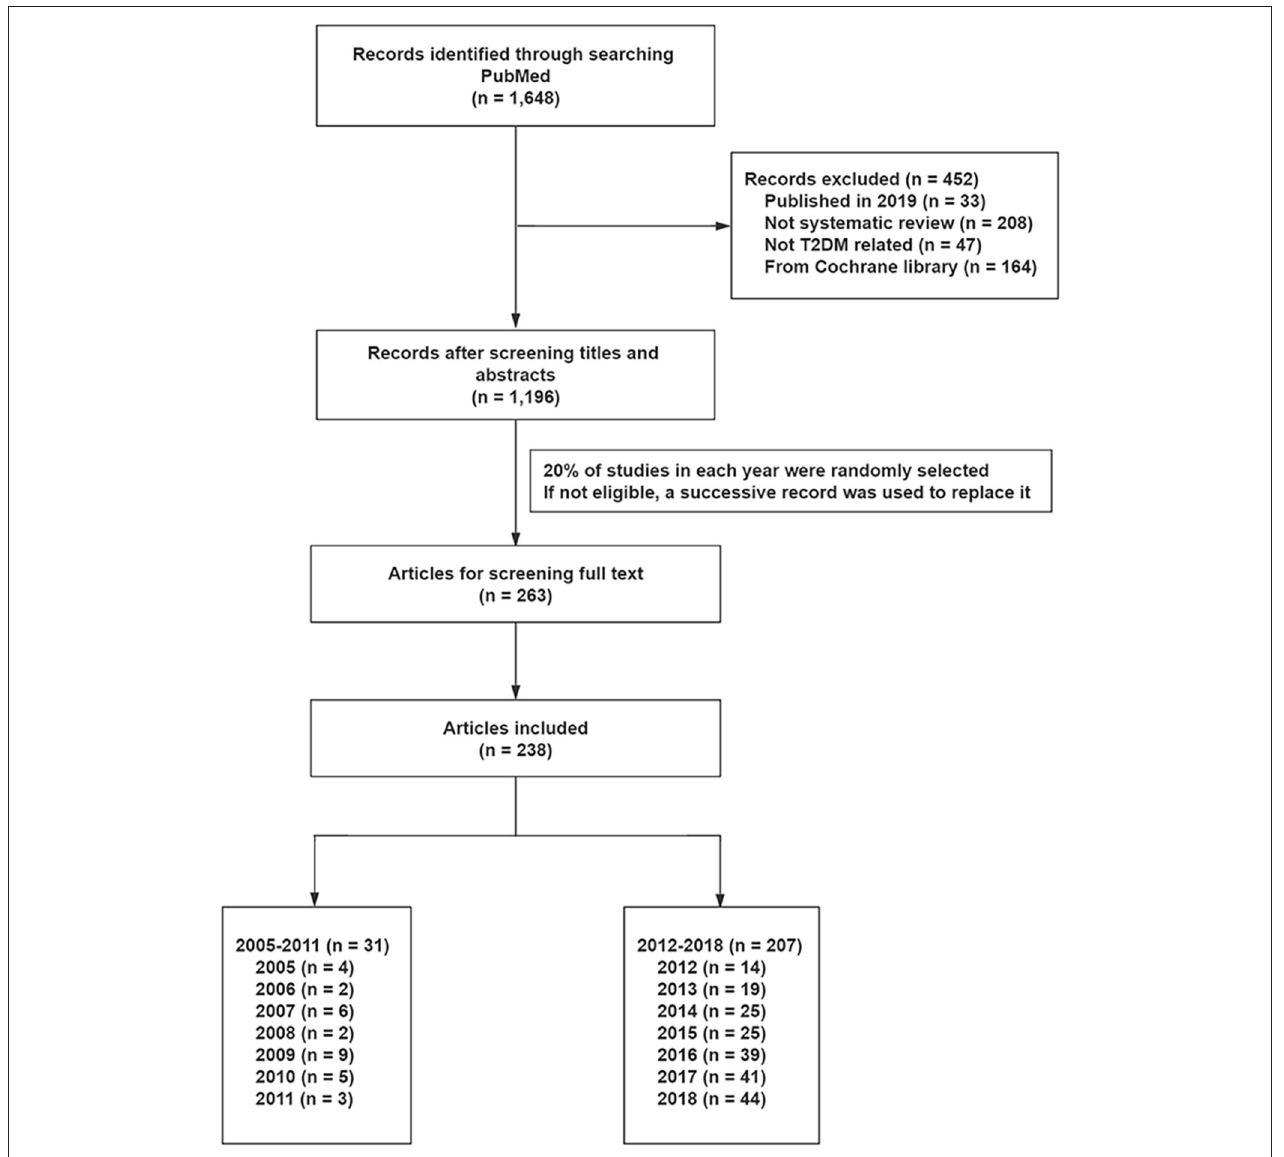
FIGURE 1 | The flow diagram of literature selection. T2DM, type 2 diabetes mellitus.